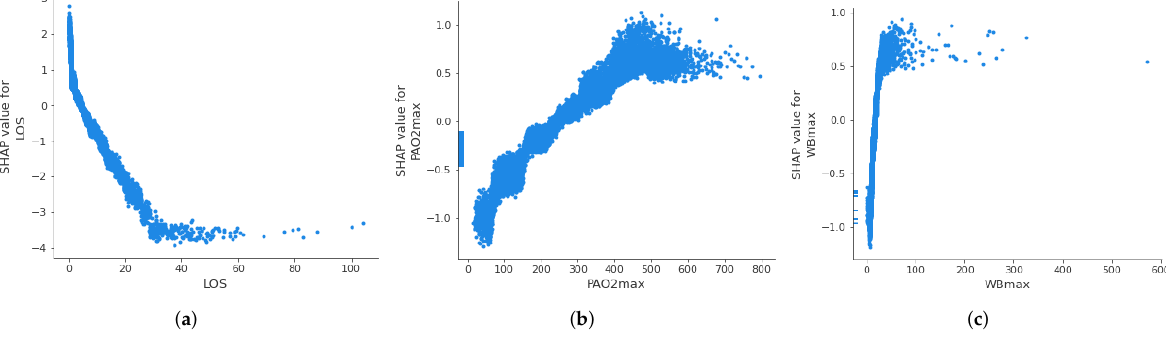
Figure 6. Partial dependence plot of the three more important features: Length of stay ( a ), maximum level of PaO 2 ( b ), and maximum level of white blood cells ( c